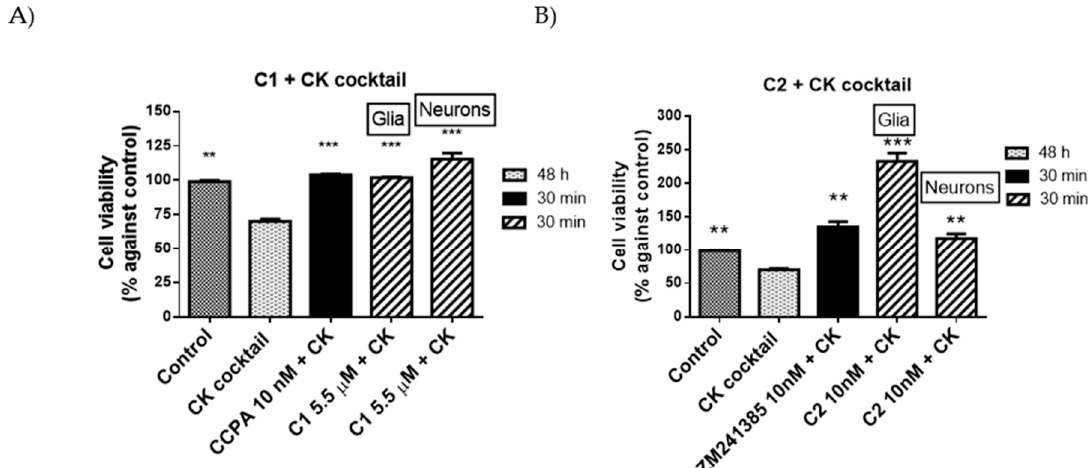
Figure 7. Protective ( A ) and restoring ( B ) effects reference compounds and compounds 1 and 2 against CK aggression on mixed glial cell culture and neurons. Percentage of cell viability after treatments. Control, CK, and reference compound results were obtained in glial cell culture. Results represent the average of 3–5 independent experiments. ** p < 0.01, *** p < 0.001 of treated cells against CK.